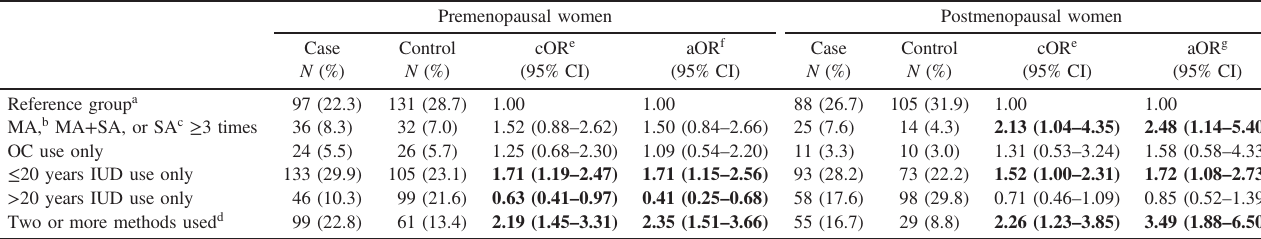
Table 4. Correlation between induced abortion, OC, and IUD use and breast cancer